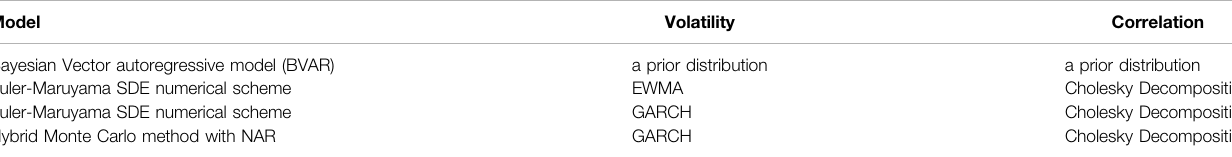
TABLE 1 | Implemented models in the Commitment